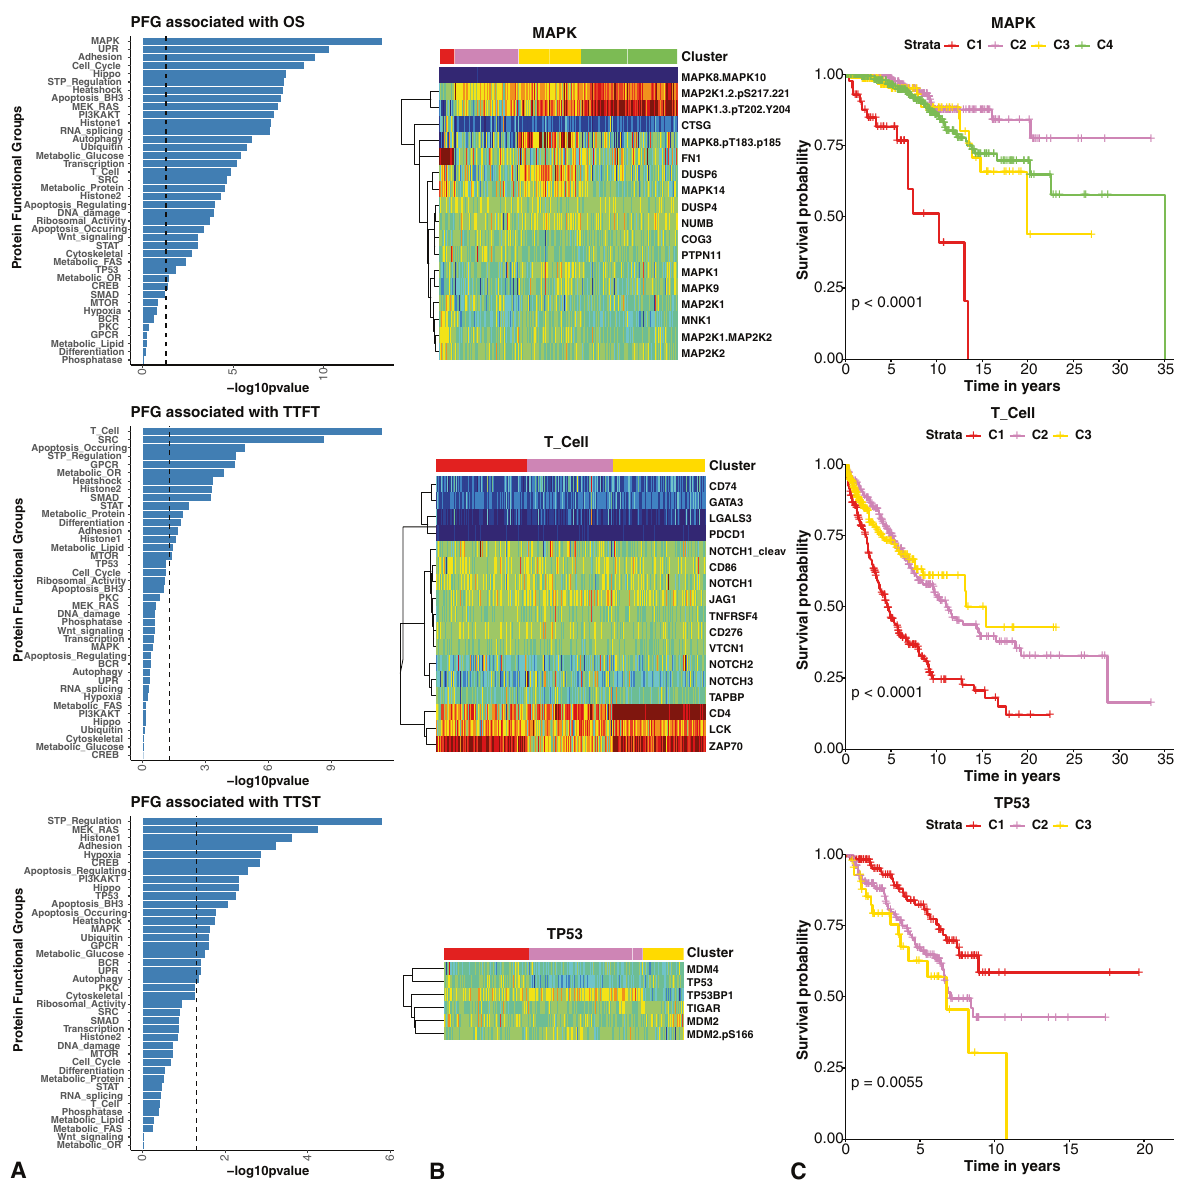
Fig. 1 Protein functional groups associated with clinical outcomes. A Kaplan – Meier signi fi cance ( x -axes) of protein functional group ( y -axes) patient clusters are displayed in barplots. Dotted lines represent the - log10 (0.05) p -value cutoff. As examples, the expression patterns of the MAPK, TCell, and TP53 PFG protein members ( B ) and their Kaplan – Meier plots ( C ) are also displayed for each